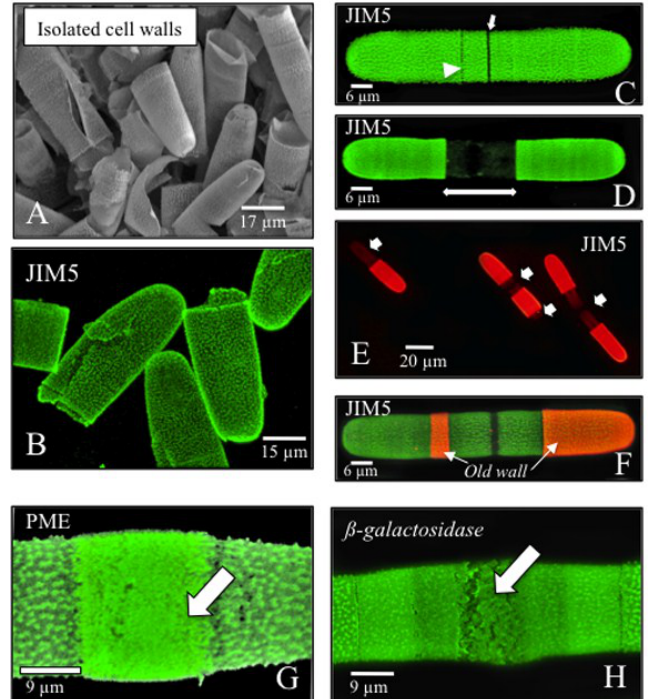
Figure 2. The cell wall and labeling with mAbs. ( A ) VPSEM image of isolated cell walls obtained through sonication (see text); ( B ) JIM5 immunofluorescence of the homogalacturonan (HG) of the outer wall layer of isolated cell walls. This mAb recognizes HG with relatively low levels of methyl-esterification. Note that the projections are clearly distinguished on the outer wall surface; ( C ) JIM5 immunofluorescence of a live cell. Most of the cell wall surface is labeled except for the isthmus (small arrow) and a lateral band (arrowhead); ( D ) After live labeling with JIM5, cells are placed back into culture. Over time, newly-deposited HG/cell wall appears as a dark zone centered at the isthmus (double arrow); ( E ) New growth zones and expansion rates in live labeled cells may be assessed using fluorescence microscopy. The surface areas of the dark zones (arrows) are measured and compared to overall cell surface area; ( F ) Live labeled cells that were allowed to grow in culture for 24 h and subsequently labeled with JIM5 that is, in turn, labeled with a different fluorophore reveals old (red) and new (green) wall regions. In this cell, the position and size of old wall regions (“old wall”, arrows) reveals an asymmetry in wall expansion [25]; ( G ) Live cell labeling with JIM5 is also used to assess alteration of the outer wall lattice. When treated with pectin methyl esterase (PME) for 24 h, the lattice at the isthmus is replaced by dense punctate labeling (arrow; see also [27]); ( H ) When cells are treated for 24 h with β-galactosidase, the lattice is disrupted